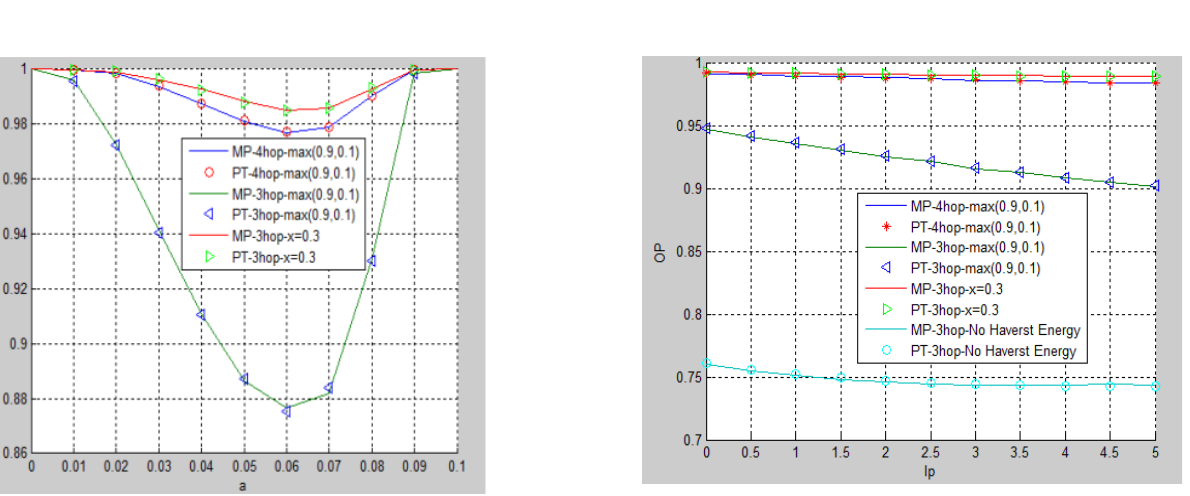
Fig. 7. OP versus a: K=3, K=4, (x PU , y PU )= (1, 1)